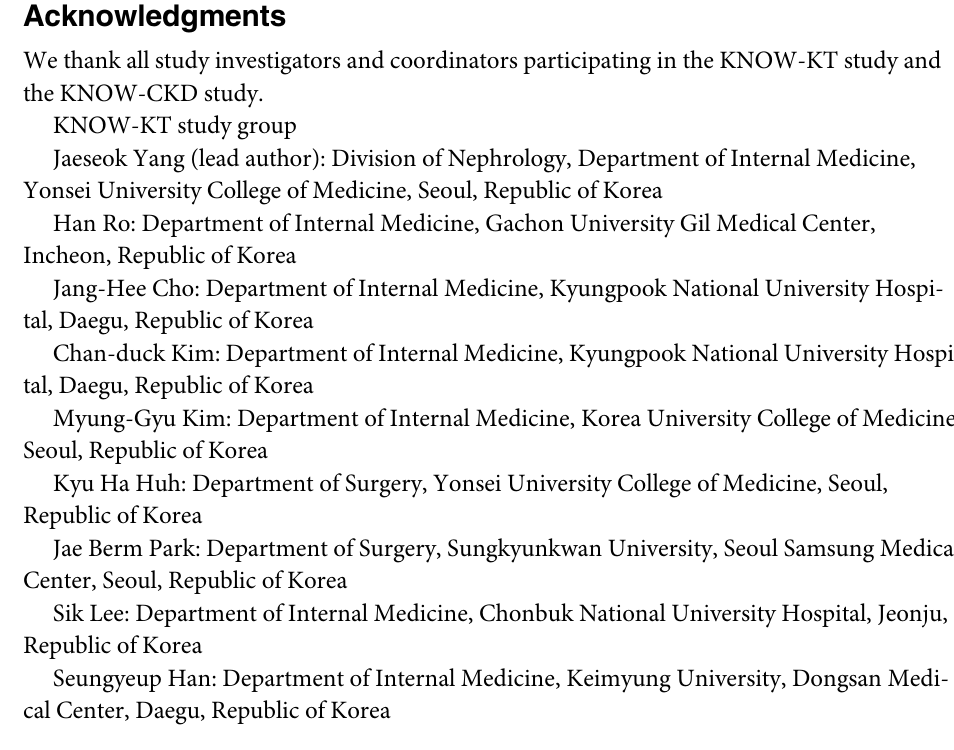
S3 Table. Prognostic factors associated with HRQOL in CKD patients. (DOCX) S4 Table. Prognostic factors associated with HRQOL in the total population including both KT and CKD patients at CKD stage 1–2. S5 Table. Prognostic factors associated with HRQOL in the total population including both KT and CKD patients at CKD stage